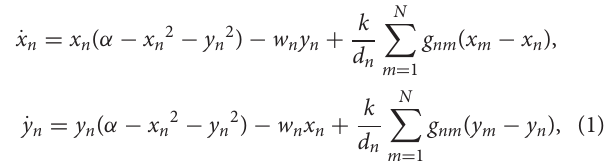
are modeled by the Stuart-Landau